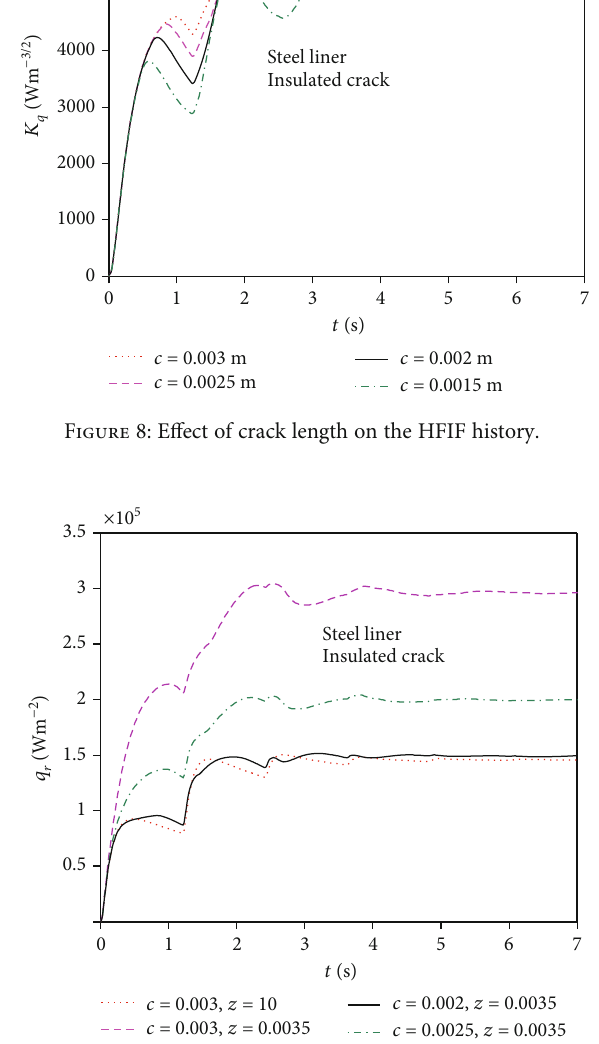
Figure 7: E ff ect of crack length on the temperature distribution along the interface plane.